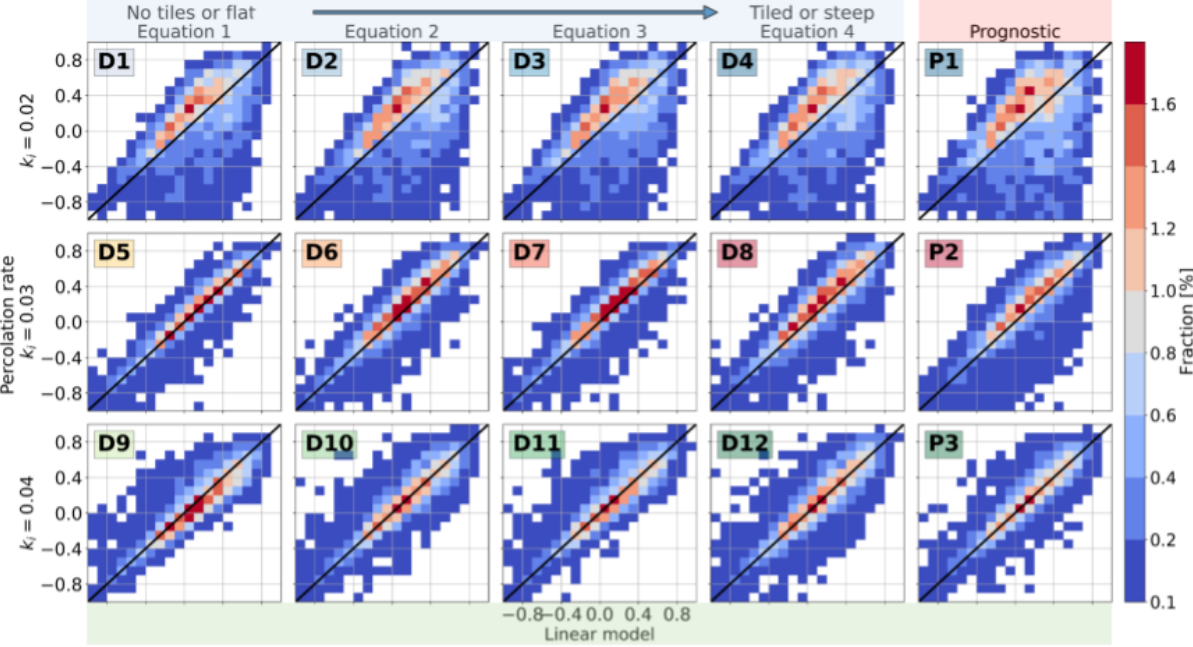
Figure 6. Event-based KGEs comparison between the diagnostics setups and the linear model. Each row corresponds to a fixed percolation rate. Columns correspond to the four fixed equations. The color bar shows the percentage of events that fall at each bin of the 2D histogram.